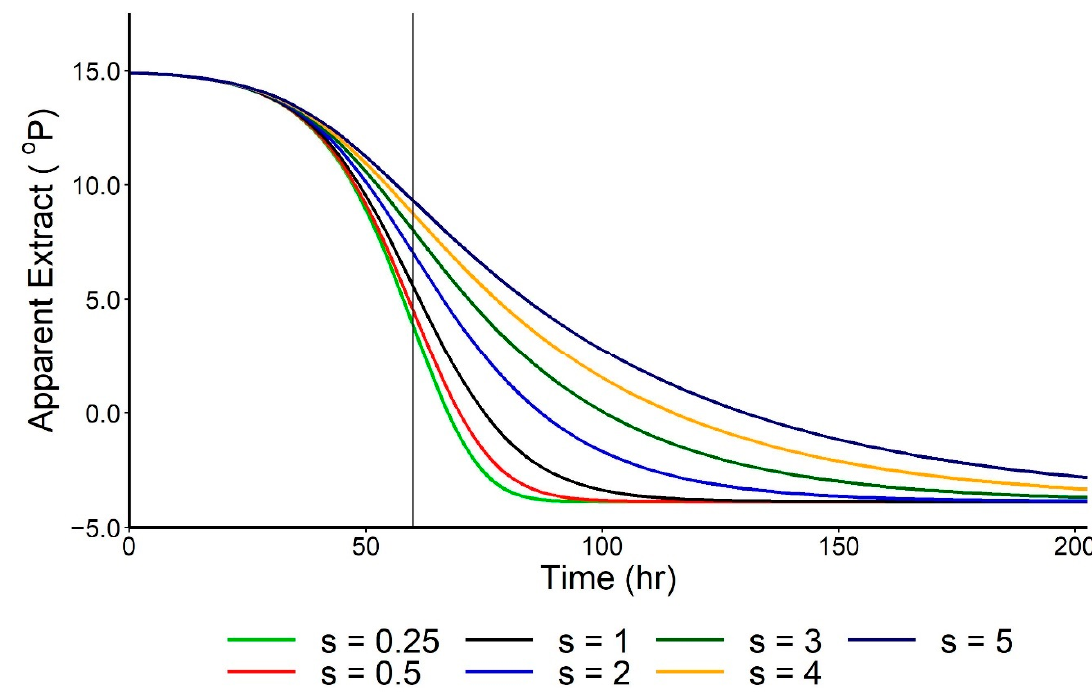
Figure 2. The generalised shape of a five-parameter logistic equation modeling the decline in density with time for a typical fermentation (showing the effect of ‘s’ parameters ranging from 0.25 to 5).